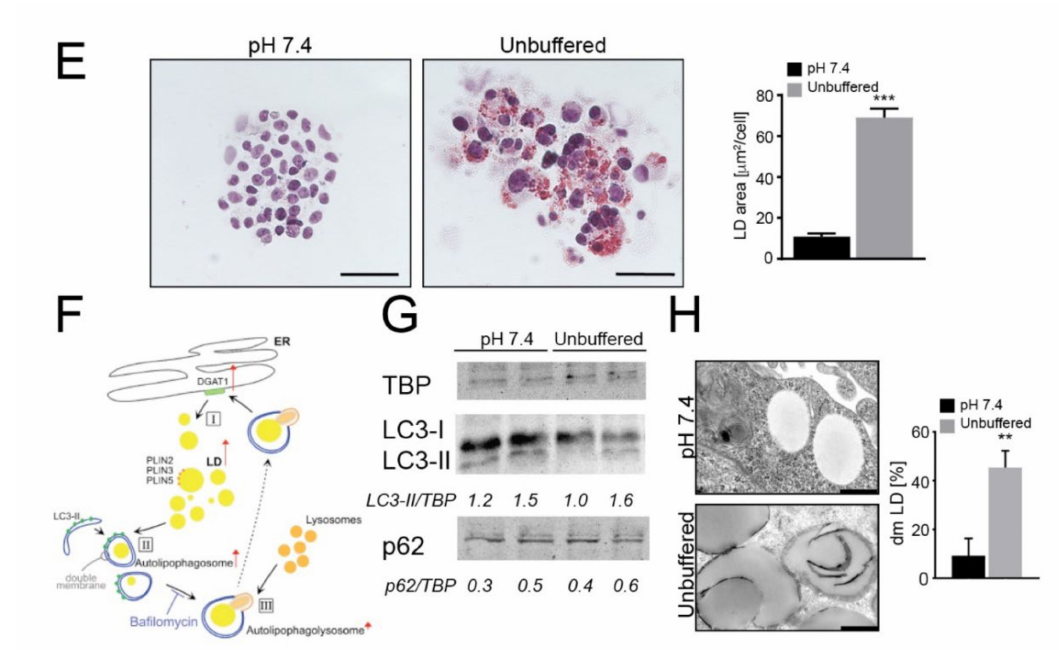
Figure 1. The acidic microenvironment promotes intracellular lipid accumulation in OS cells. ( A – C ) Tumor tissues from OS patients stained with Nile Red (for LD, yellow), the acidic marker Lamp2 (red), nuclear staining with Hoechst (blue) ( A ), and with Oil Red O for bright field visualization (counterstaining with hematoxylin) ( B ), or visualized by EM ( C ); scale bars: Nile Red O and Lamp2, 50 µ m; Oil Red O, 100 µ m; EM, 2 µ m; ( D ) EM of 143B spheroids cultured for 96 h in neutral or unbuffered medium. Arrowheads indicate autophagosomes, whereas asterisks indicate membrane-enclosed LD. Scale bar: 2 µ m; ( E ) Oil Red O staining of 143B spheroids cultured for 96 hrs in neutral or acidic medium (counterstained with hematoxylin). Scale bar: 100 µ m. Right panel shows quantification of Oil Red O images. Data presented as mean ± S.E.M of n = 10 different fields from 3 independent experiments (unpaired two-tailed Mann-Whitney test; *** p < 0.001); ( F ) Schematic representation of the autophagic process: free FA are conveyed into LD from the ER, a process that is regulated by DGAT1 activity (I); autophagosome fuse with LD to form LC3-II-expressing autolipophagosome with double membranes (II); autolipophagosome fuse with lysosomes to form autolipophagolysosome (III); ( G ) Immunoblots of homogenates of 143B spheroids cultured for 5 days. Cells were treated with a saturating dose (50 nM) of bafilomycin A1, during the last 4 h of incubation to improve the detection of autophagic components. The protein expression levels of LC3-II and p62 were quantified with ImageJ software analysis and normalized to those of the housekeeping gene TBP. n = 3 independent experiments; ( H ) EM analysis of LD in 143B spheroids. The graph shows the percentage of cells containing double- membrane (dm) droplets relative to the number of cells containing LD. Scale bar: 500 nm; Data presented as mean ± S.E.M of n = 7 different fields from 3 independent experiments (unpaired two-tailed Mann-Whitney test; ** p <